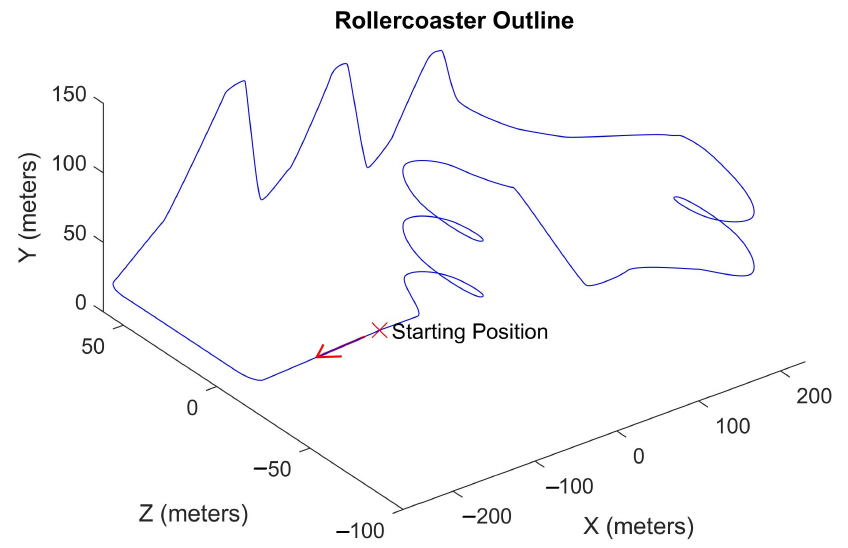
Figure 8. Rollercoaster track outline. The arrow indicates the direction of motion. The coordinate sys- tem follows the convention used in Unity, i.e., X: right direction; Y: up direction; Z: forward